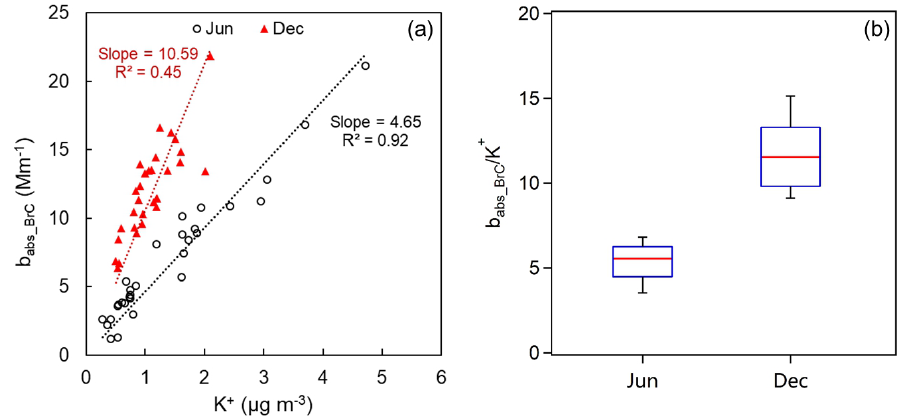
Figure 8. (a) Correlations between daily average b abs_BrC and K + mass concentration in June (black circles) and December (red triangles) and (b) boxplot of b abs_BrC / K + ratio in June and December (data are from the year 2014), where red lines represent the median value, blue boxes represent 25th and 75th percentile ranges and thin bars are 5th and 95th